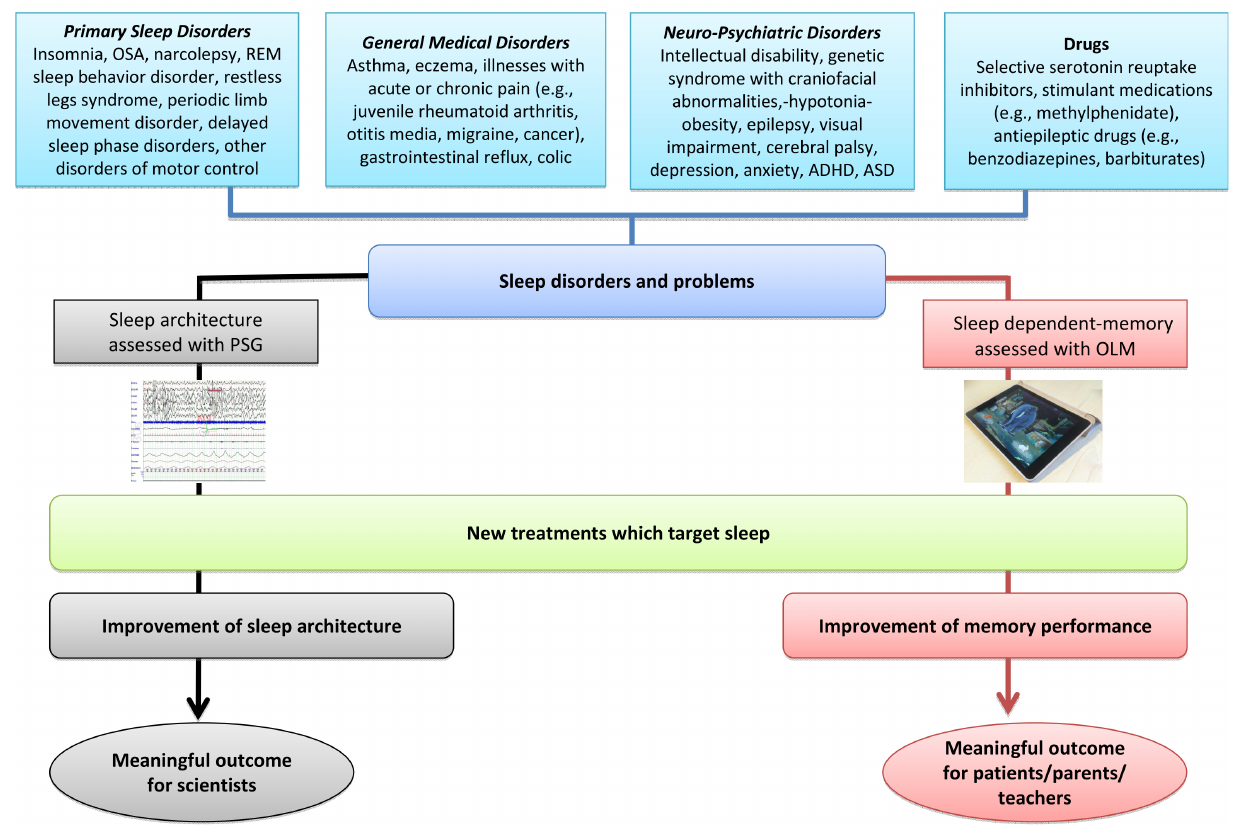
FIGURE 2 | Routes for assessing the effect of intervention in sleep disruption. OLM, overnight learning measure; OSA, obstructive sleep apnea; PSG, polysomnography; REM, rapid eye